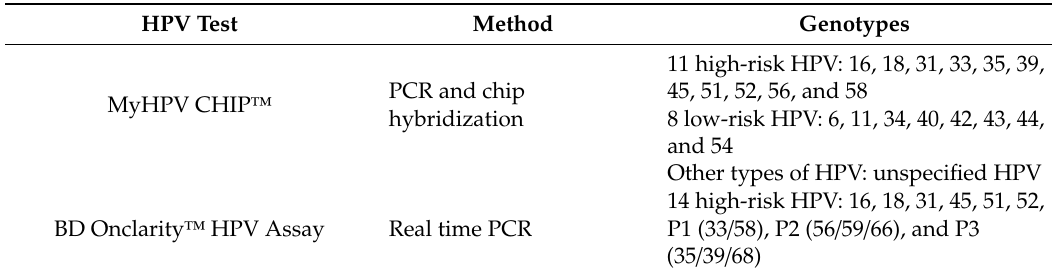
Table 1. Methods of HPV (Human Papillomavirus)